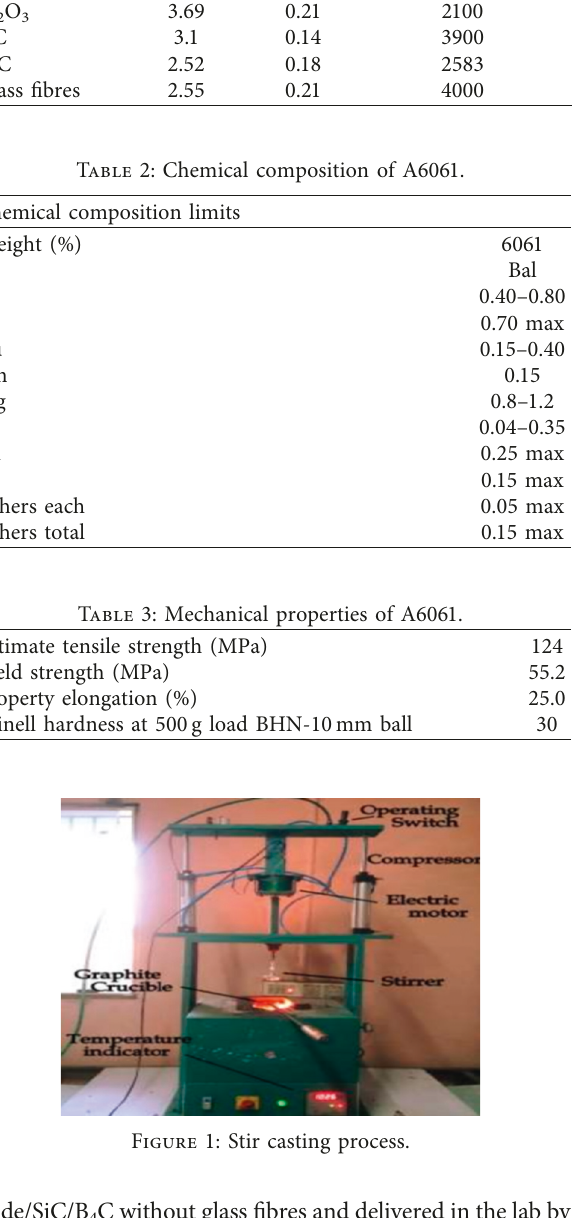
Table 1: Mechanical properties of Al